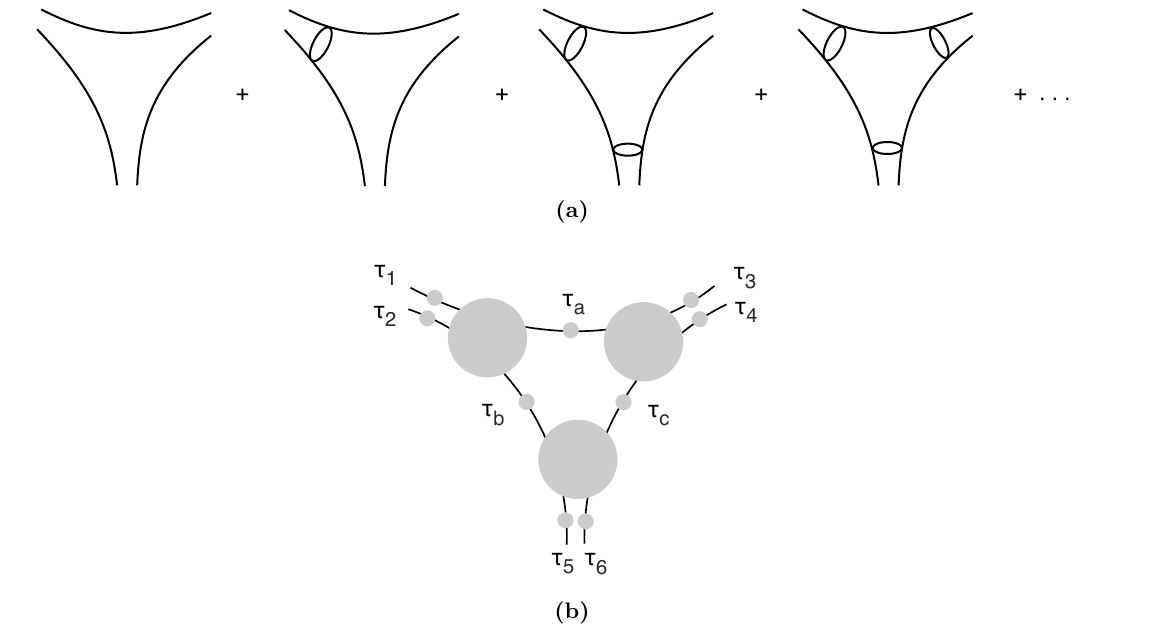
Figure 6. The second set of diagrams (planar diagrams) contributing to the six-point function at order 1 =N 2 . These diagrams can be compactly drawn as three (partially amputated) four-point functions glued together, see eq. (3.4) . The large shaded circles are the 1PI four-point functions. The small shaded circles denote dressing the two-point function; we have made this explicit here, while it is implicit in all other (cid:12)gures.